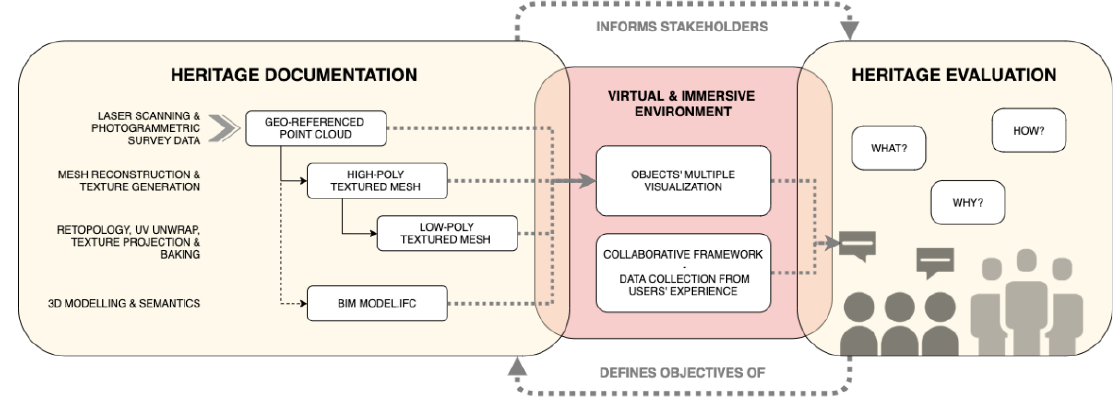
Figure 2. This scheme represents the methodological framework adopted in this research. The multiple visualization and the collaboration framework implemented in game engines support the strategic planning of heritage recording activities as they enhance the iterative process between heritage documentation and evaluation. The objectives of documentation are then gradually specified according to the values associated with heritage